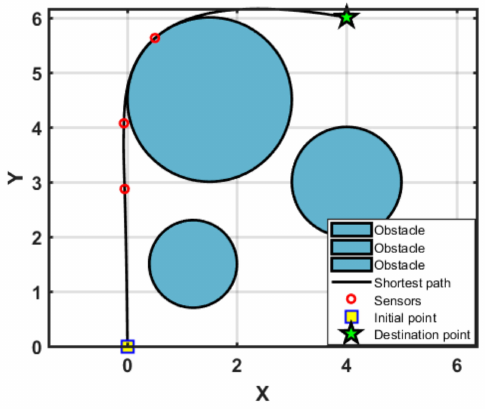
Figure 7. Particle swarm optimization (PSO)-based shortest-path